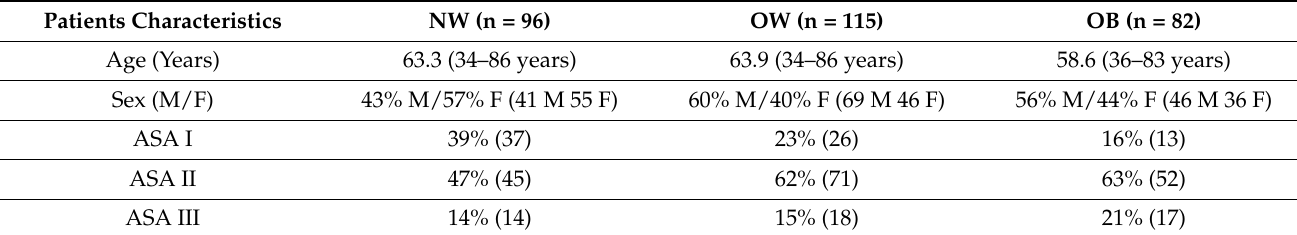
Table 1. Surgery-related parameters.